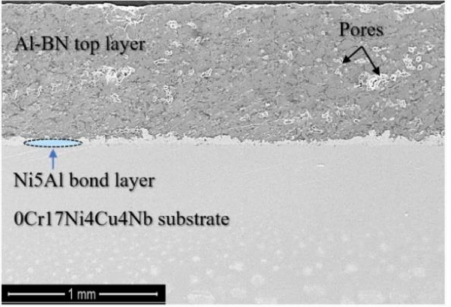
Figure 1. Cross-sectional morphologies of the prepared Al–BN ACS.